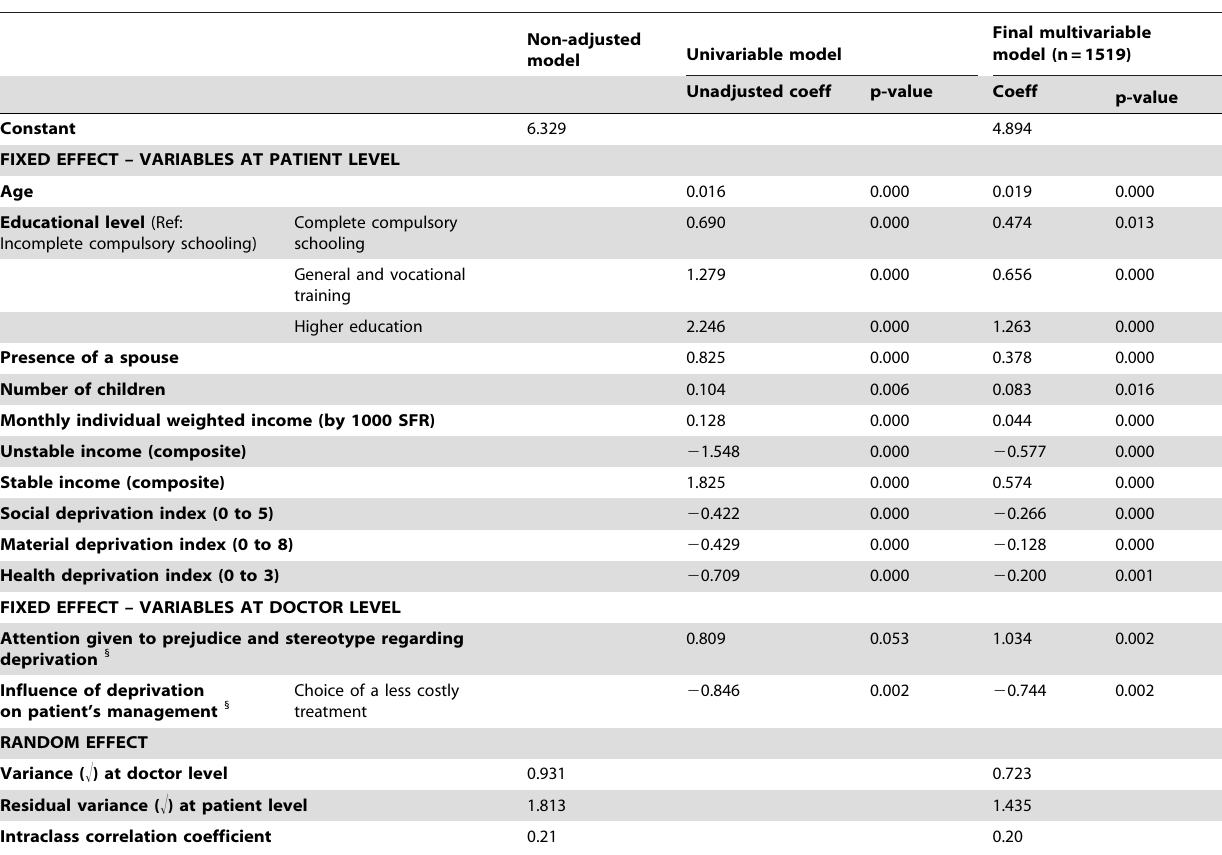
Table 5. Multivariable analysis of GP’s evaluation of patient social